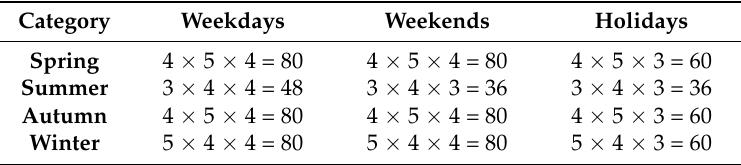
Table 1. The number of scenarios in the typical timing characteristics.